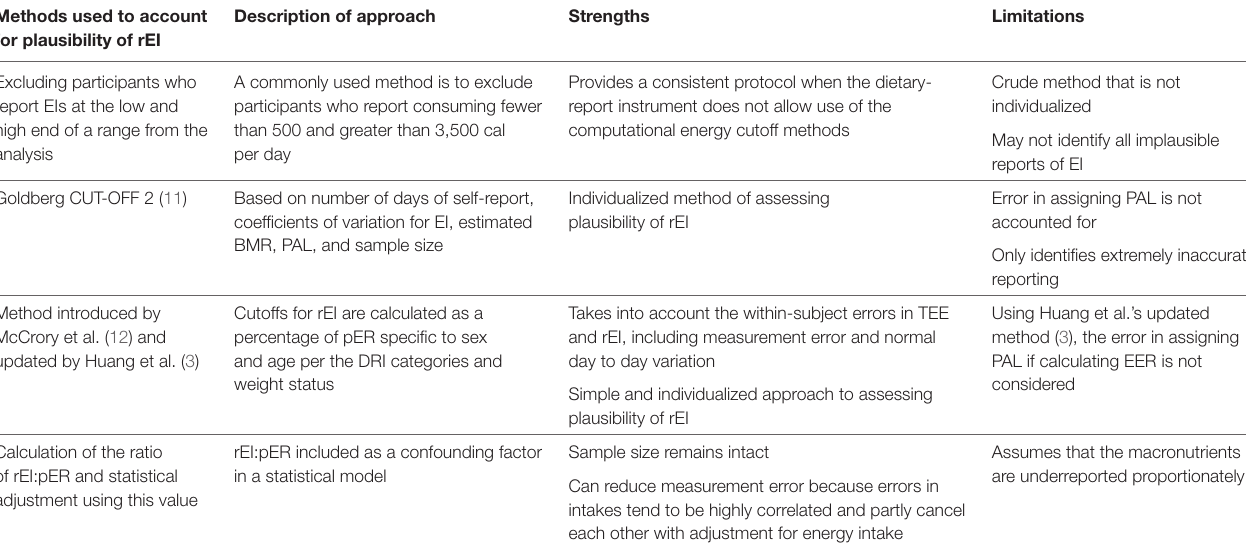
table 2 | Overview of methods used to account for plausibility of